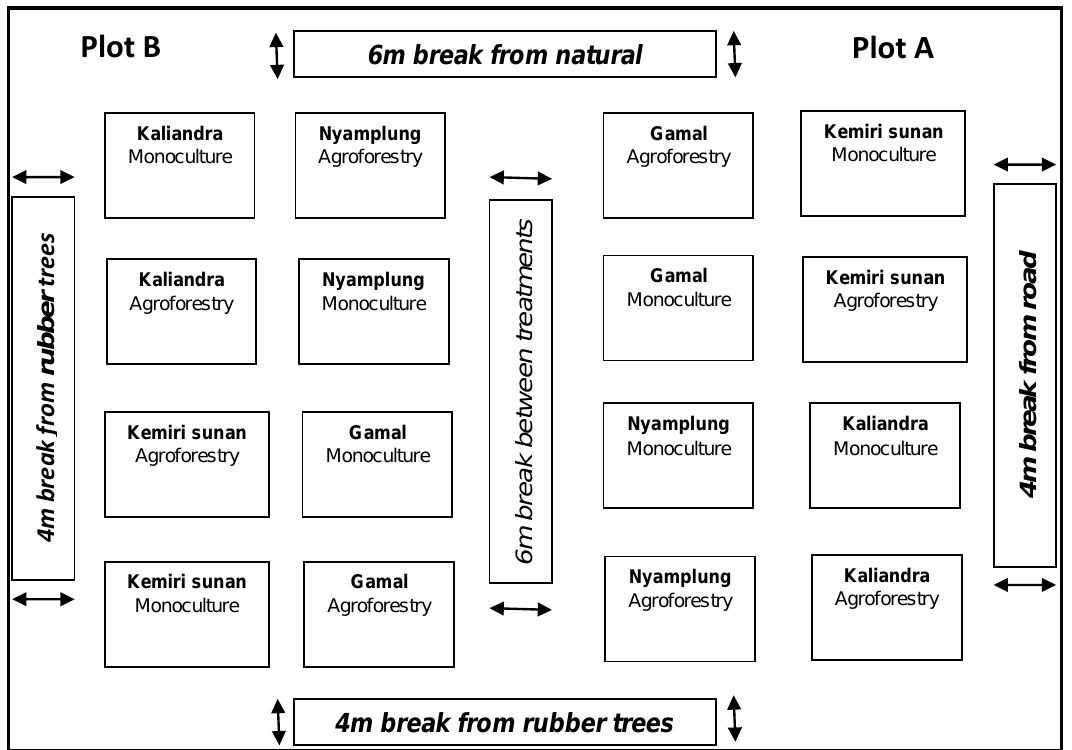
Figure 3. Split plot design for the treatment of four biofuel species in Buntoi research site in Pulang Pisau, Central